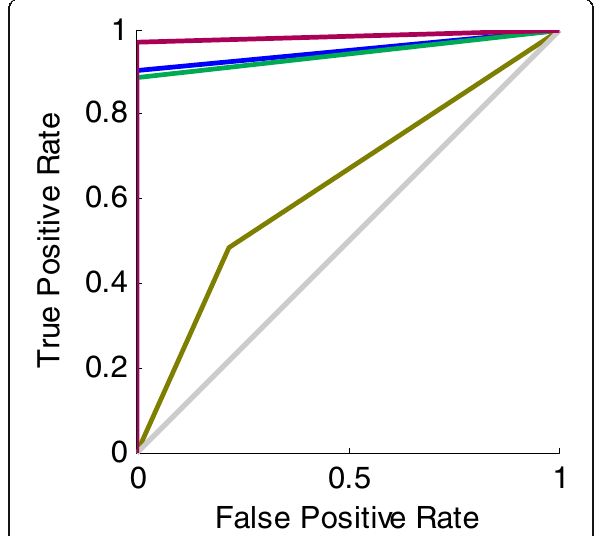
Fig. 8 ROC curves. As shown in the figure, the purple curve is the ROC of combined features. The blue curve is the ROC of color features. The green curve is the ROC of texture features, and the soil green curve is the ROC of shape